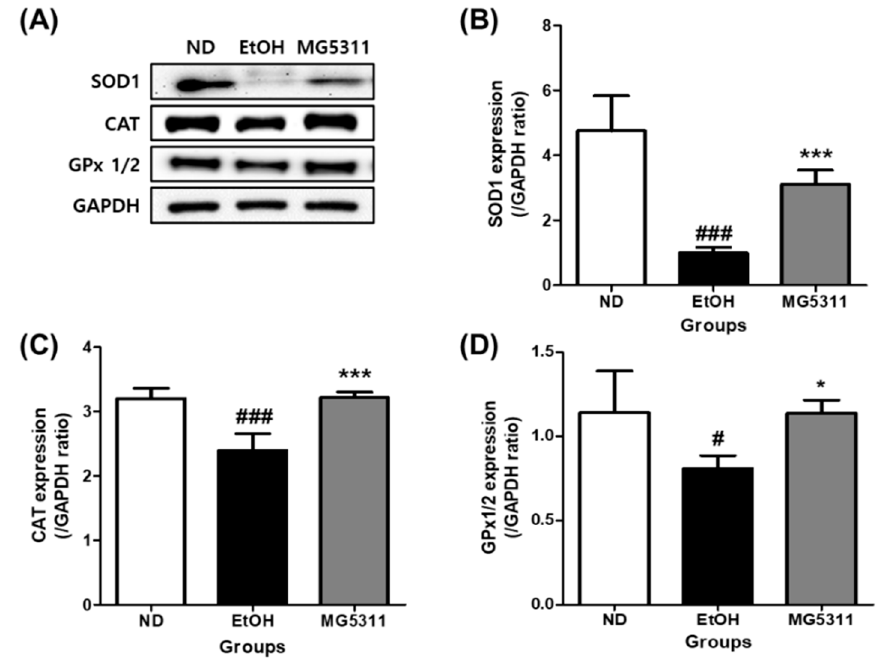
Figure 5. Effect of L. brevis MG5311 on protein expression of antioxidant enzymes in the liver tissue of ethanol-fed mice. ( A ) representative Western blot; ( B ) superoxide dismutase 1 (SOD1); ( C ) catalase (CAT); and ( D ) glutathione peroxidase 1/2 (GPx 1/2). Data are presented as mean ± SD ( n = 3). Significance was analyzed by Dunnett’s test. # p < 0.05, ### p < 0.001 vs. ND group. * p < 0.05, *** p < 0.001 vs. EtOH group. ND, normal diet group; EtOH, ethanol diet group; MG5311, ethanol diet- L. brevis MG5311 administered group.